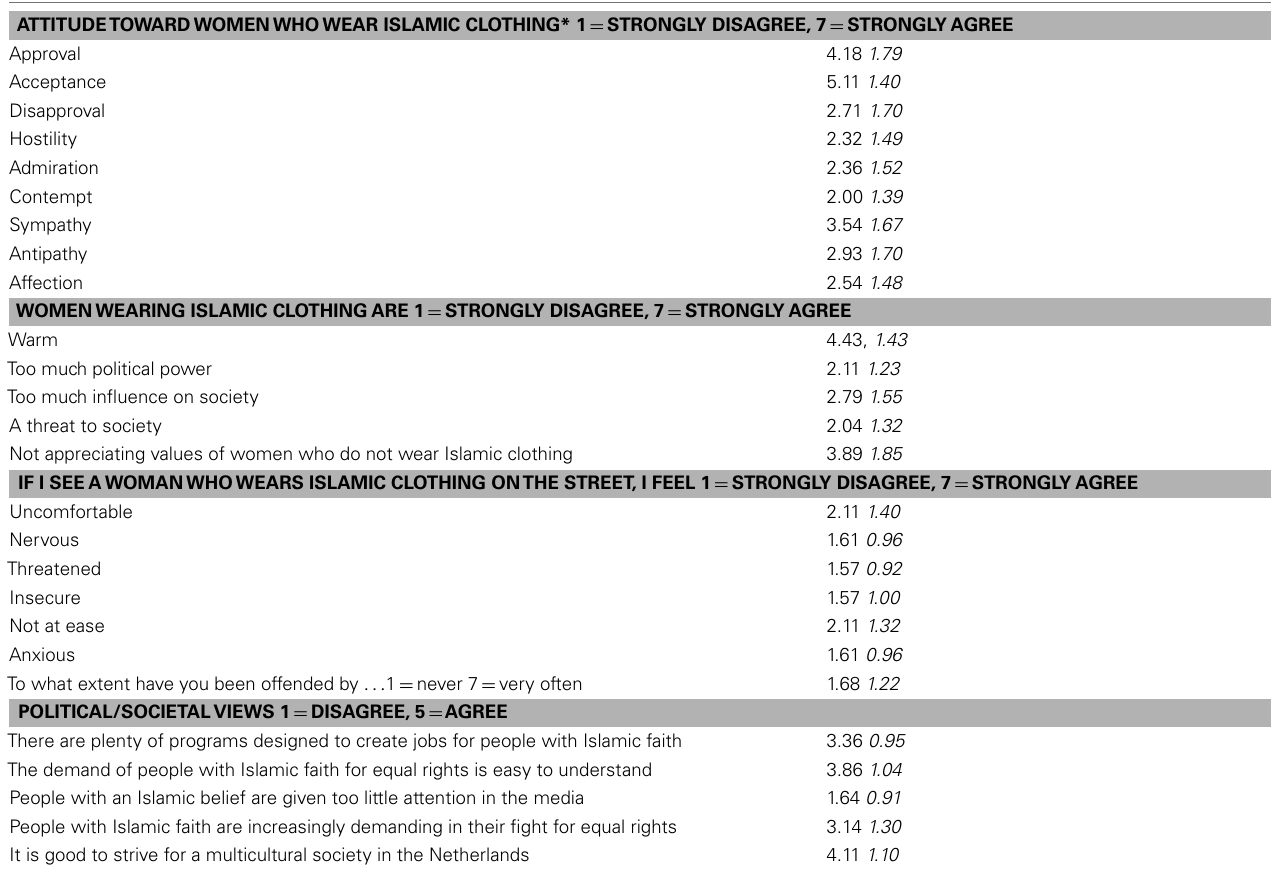
Table 3 |Attitudes toward women wearing Islamic clothing and toward the Islam in